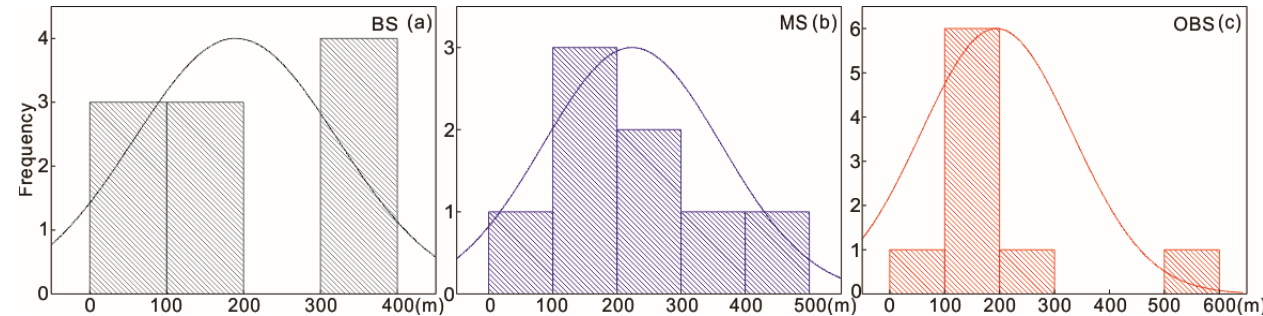
Figure 6. Histograms of burial depth versus granite sample type. ( a ) Barren samples, ( b ) Mineralized samples, ( c ) Ore-bearing samples. samples, ( c ) Ore-bearing